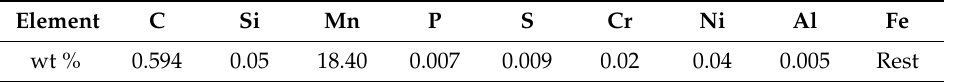
Table 1. Chemical composition of the investigated Fe-18Mn-0.6C steel in wt %.